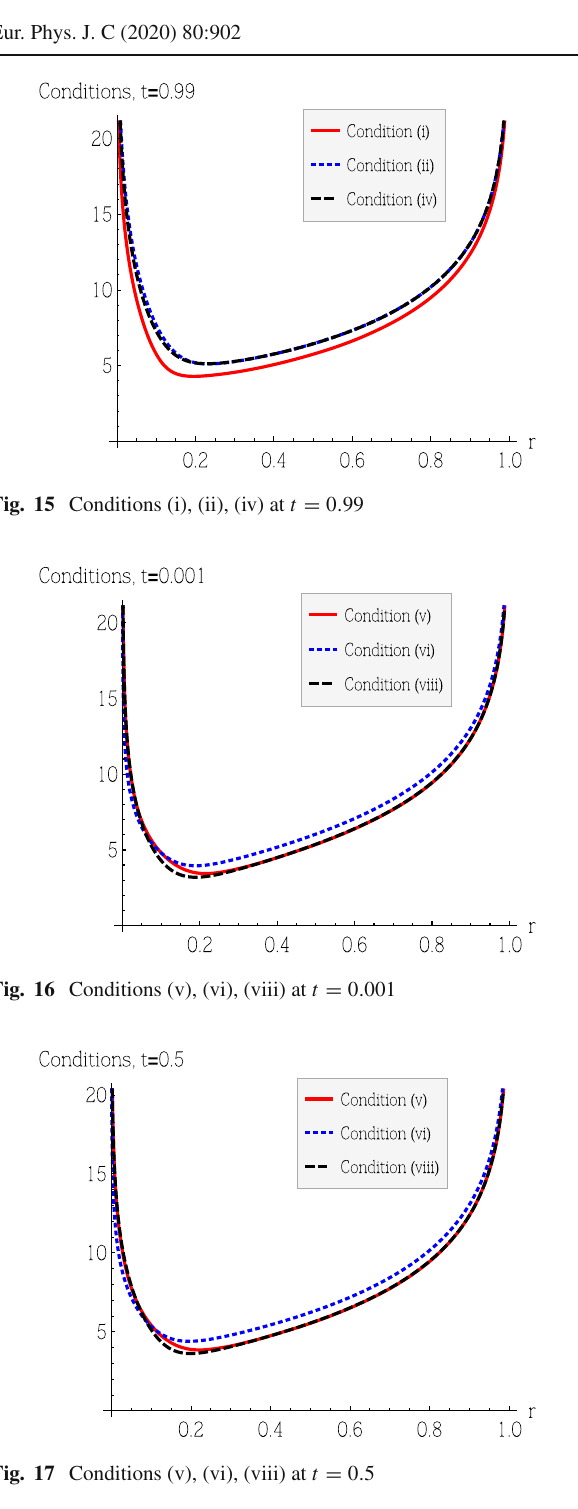
at the conditions (i), (ii) of Eq. (18) and (iv), (v), (vi) and (viii) of Eq. (20). Snapshots of the logarithms of the relevant quan- tities on the left hand side of the corresponding equations at t = 0 . 001, t = 0 . 05 and t = 0 . 99 are shown in Figs. 13, 14, 15, 16, 17, 18. In Figs. 13, 14 and 15, the thick red, dot- ted blue and dashed black lines represent the logarithms of